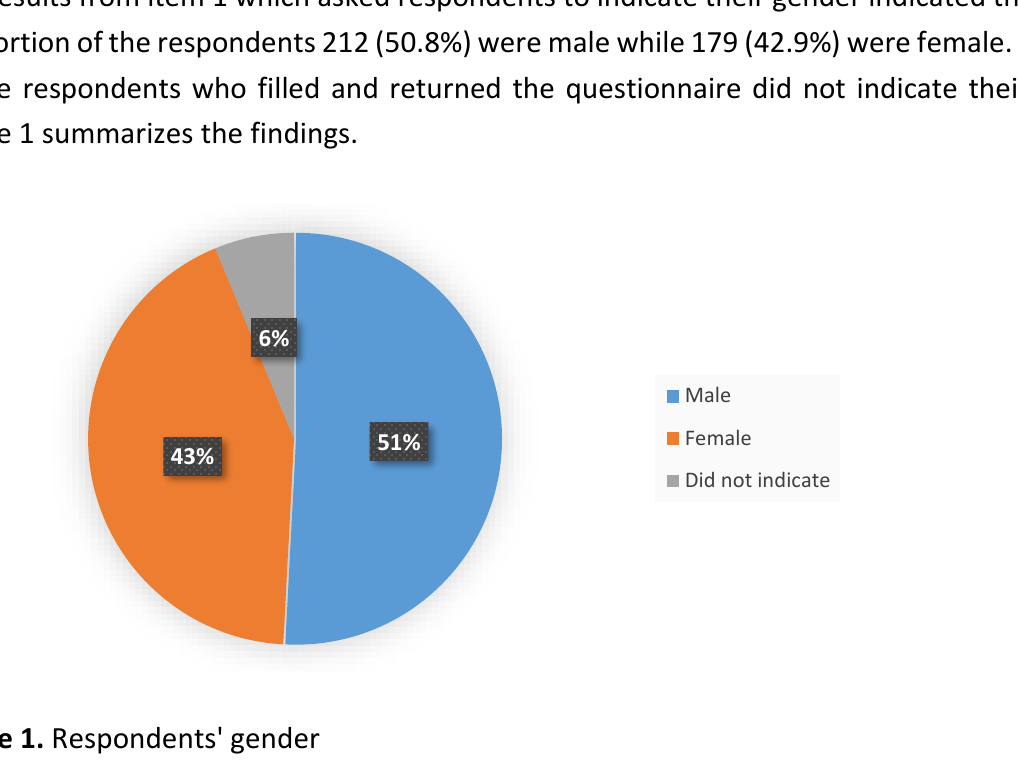
Figure 1. Respondents'